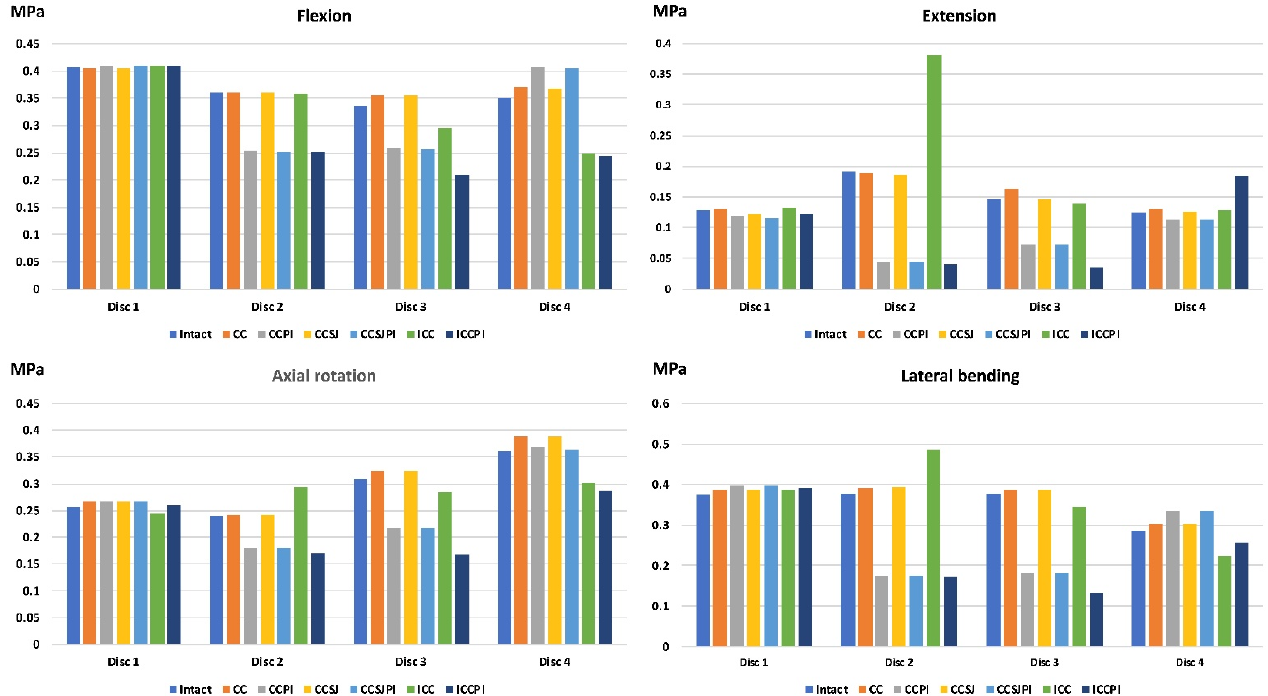
Figure 7. The results of nucleus stress.